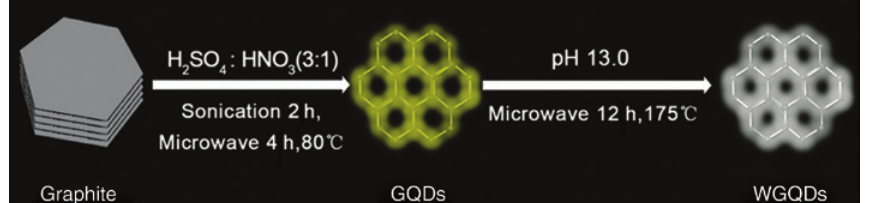
Figure 10: Schematic presentation of preparing WGQDs. (reprinted/reproduced with the permission of Ref. [84], copyright 2016, Wiley-VCH Verlag GmbH &